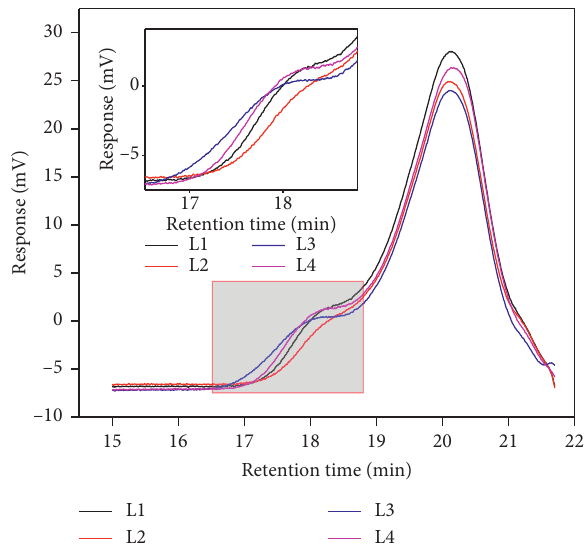
Figure 6: GPC curves of asphalt at different layers.